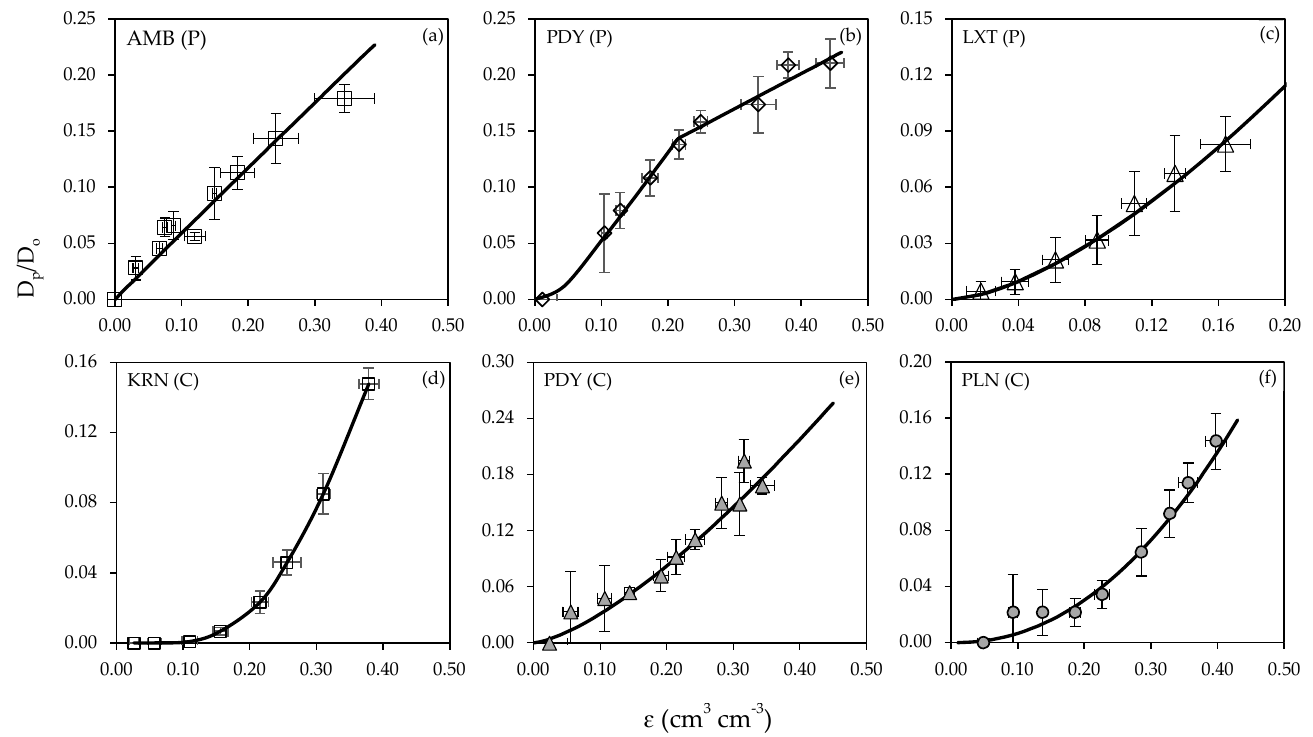
Figure 01 Figure 1. Measured soil-gas diffusivity against air-filled porosity for six intact soils ( a – f ), together with the descriptive two-region model (Equations (6) and (7)). AMB; Ambewela (Sri Lanka), PDY; Peradeniya (Sri Lanka), LXT; Lexington (United Kingdom), KRN; Kurunegala (Sri Lanka); PLN; Polonnaruwa (Sri Lanka). P and C in parentheses denote Pasture and Cultivated,